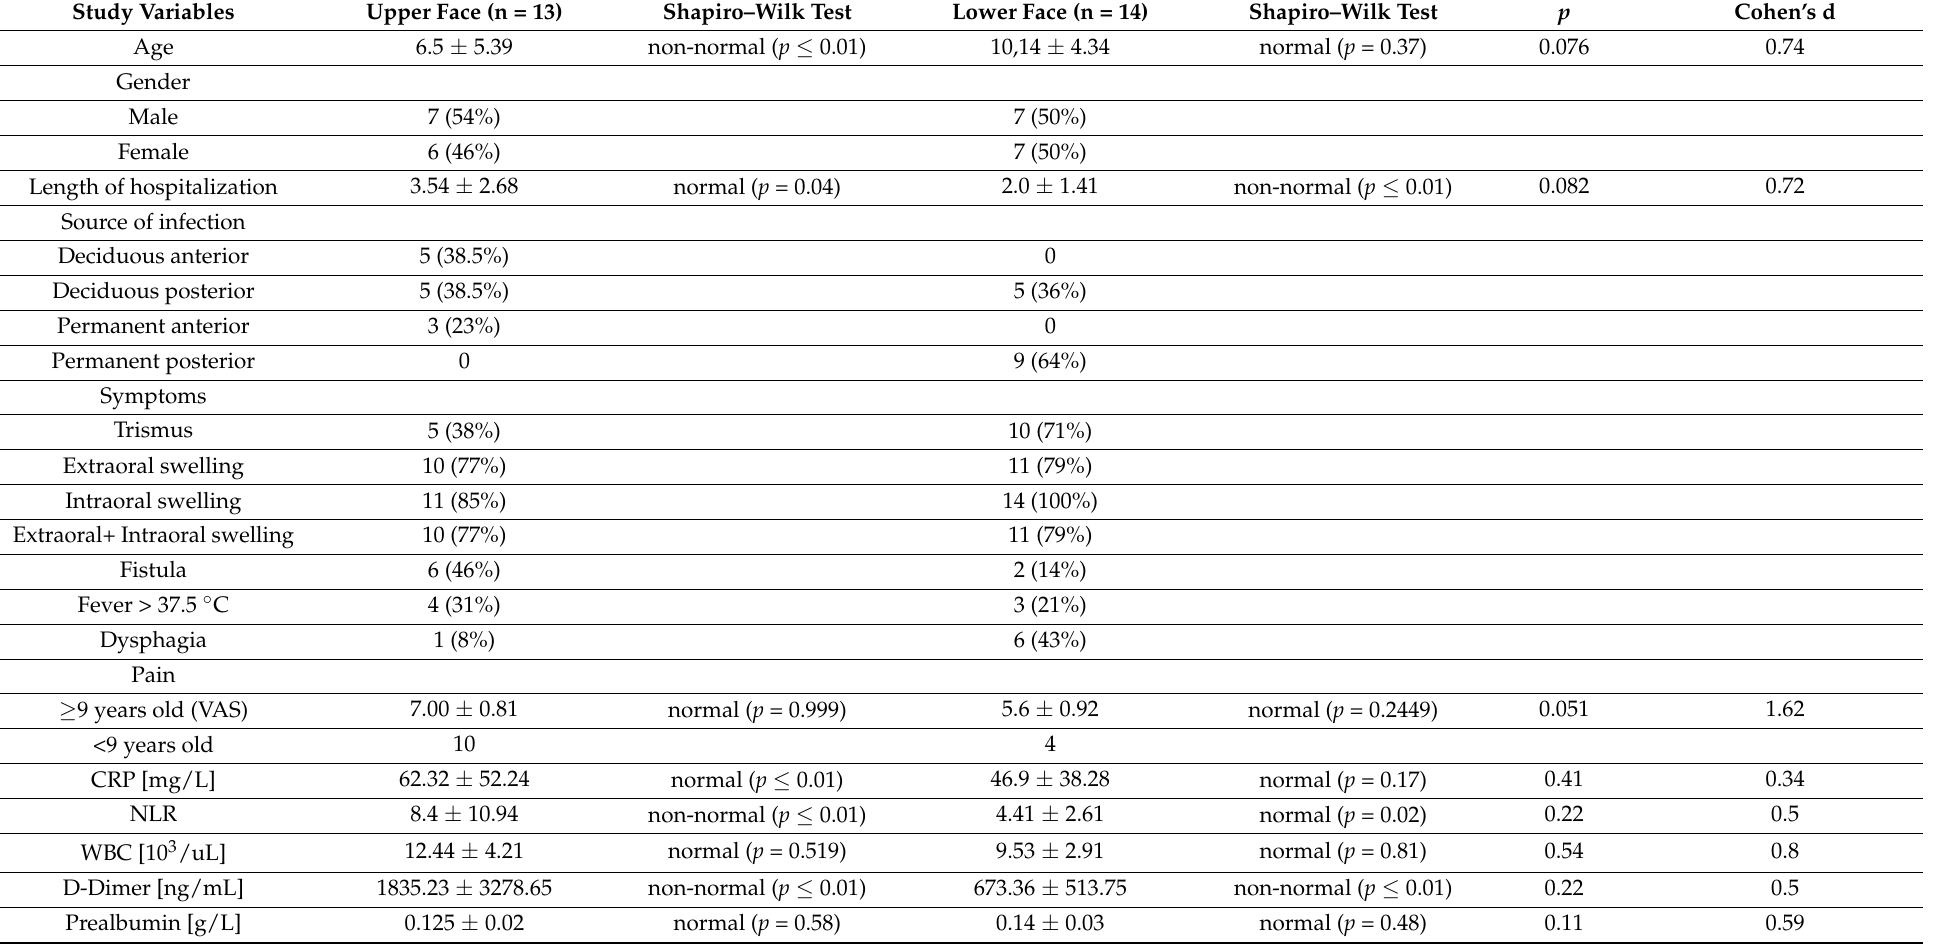
Table 1. Comparison of upper- and lower-face odontogenic